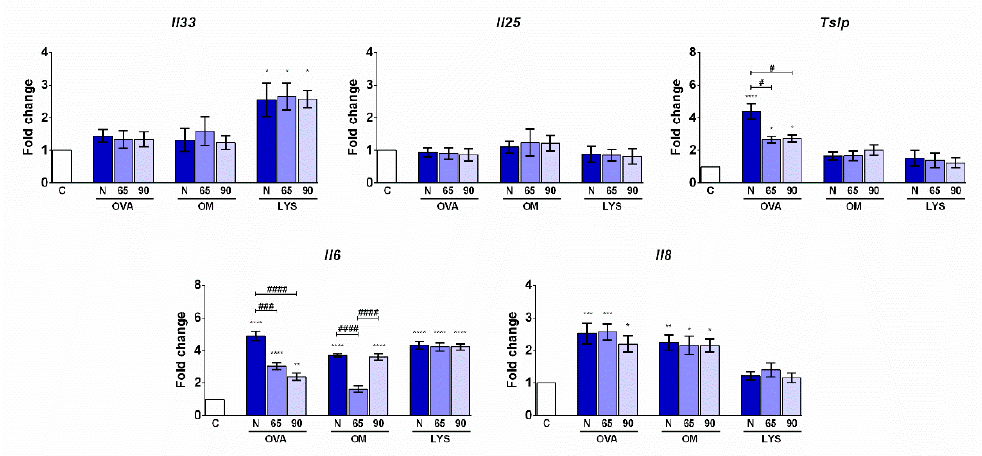
Figure 4. Relative gene expression of Il33 , Il25 , Tslp , Il6 , and Il8 in Caco-2 cells after incubation with peptides (<10 kDa) generated during digestion of native (N) egg white proteins or subjected to two different heat treatments, 65 °C for 30 min (65) and 90 °C for 3 min (90). Asterisks and pounds indicate statistically significant differences with respect to the cells incubated with PBS (C) or between experimental groups, respectively. * and # p < 0.05; ** p < 0.01; *** and ### p < 0.001; **** and #### p < 0.0001.